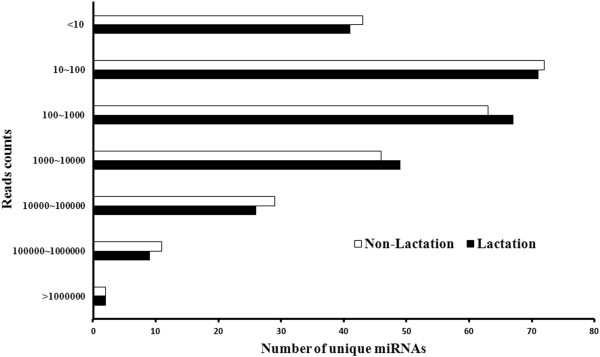
The distribution of the sequencing reads of known bovine miRNAs. The read counts of known bovine miRNAs in lactating and non-lactating mammary glands were classified. The known miRNAs had a broad range of expression levels in the MG, ranging from hundreds of thousands of sequence reads for the most abundant miRNAs to single reads for the least abundant.